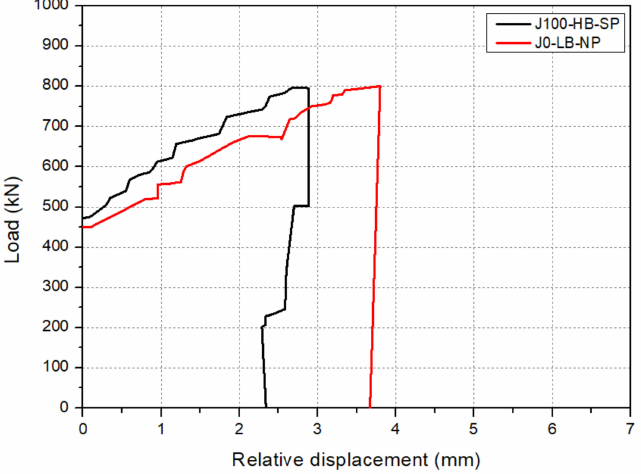
Figure 7. Load–relative displacement curves according to rebar type and presence of steel